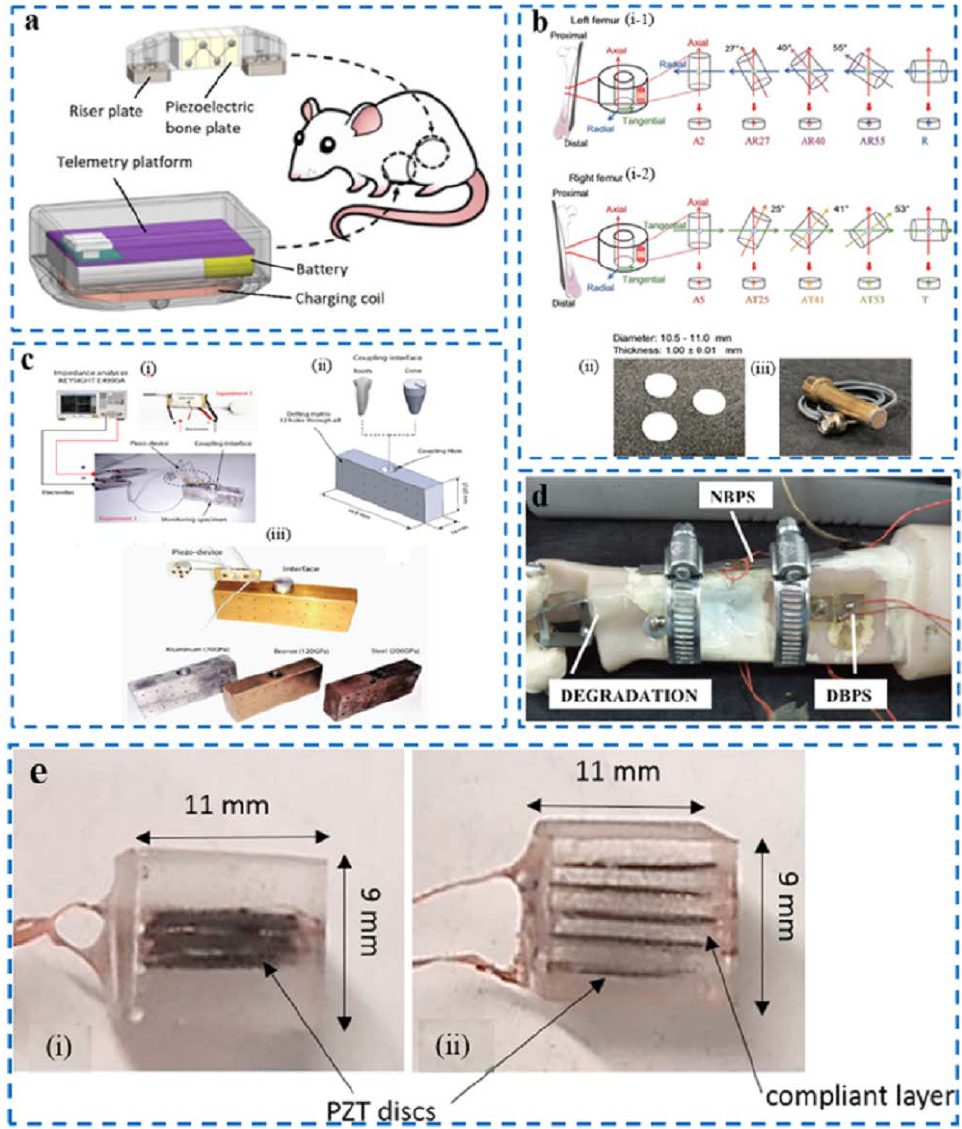
Figure 7. ( a ) Piezoelectric fixation plate mounted on the femur of a rat [81] ; ( b ) (i) preparation of bone samples, (i-1) bone plate sample of left femoral specimen, (i-2) bone plate sample of right femoral specimen, (ii) photograph of the bone plate, and (iii) bone ultrasound transducer [82]; ( c ) (i) experimental apparatus for mechanical electrical impedance measurements, (ii) the dimensions and materials of the monitoring structure, and (iii) materials used for the experiment [83]; ( d ) bones with DBPS and NBPS configurations [84]; ( e ) compliant layer adaptive composite stacks (i) 0.0 mm CLACS, and (ii) 0.8 mm CLACS [85] .